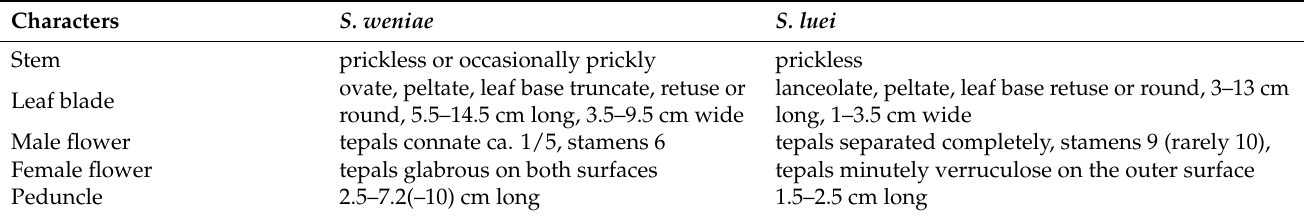
Table 1. Morphological comparison between Smilax weniae and Smilax luei T.